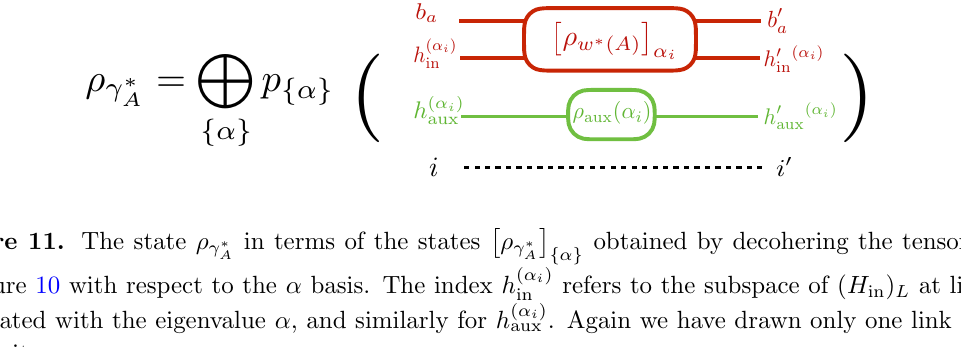
(cid:13) (cid:3) A in terms of the states